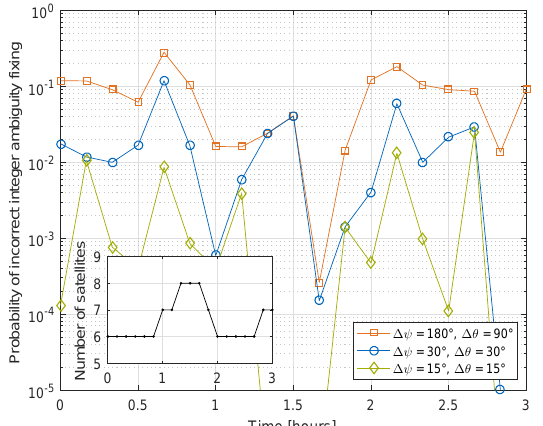
Figure 3. Benefit of magnetometer-based prior attitude information for single epoch integer ambiguity fixing: the probability varies over time due to the changing satellite